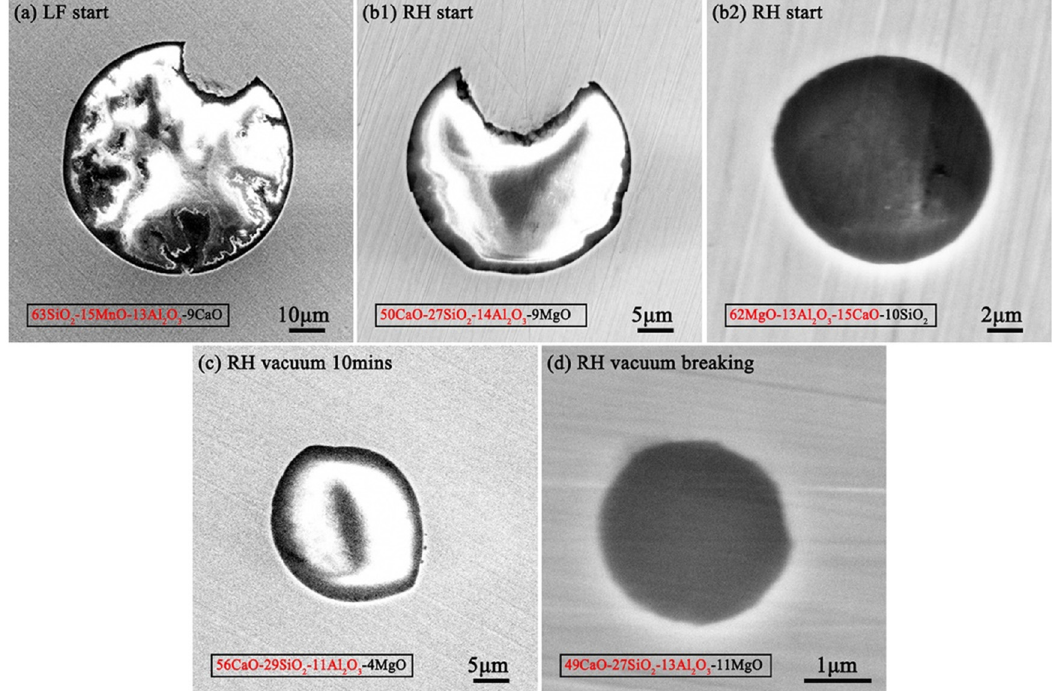
Figure 2: Morphology and chemical composition of typical inclusions during the LF – RH re fi ning process in heavy rail steel: ( a ) LF start; ( b1 and b2 ) RH start; ( c ) RH vacuum holding for 10 min; and ( d ) RH vacuum